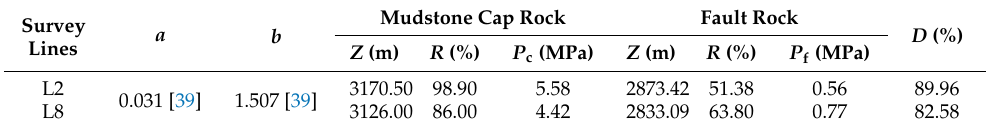
Table 2. Calculation of the degree of damage by the F1 Fault to the sealing ability of the mudstone cap rock of E 3 d 2 in the partial destruction stage.